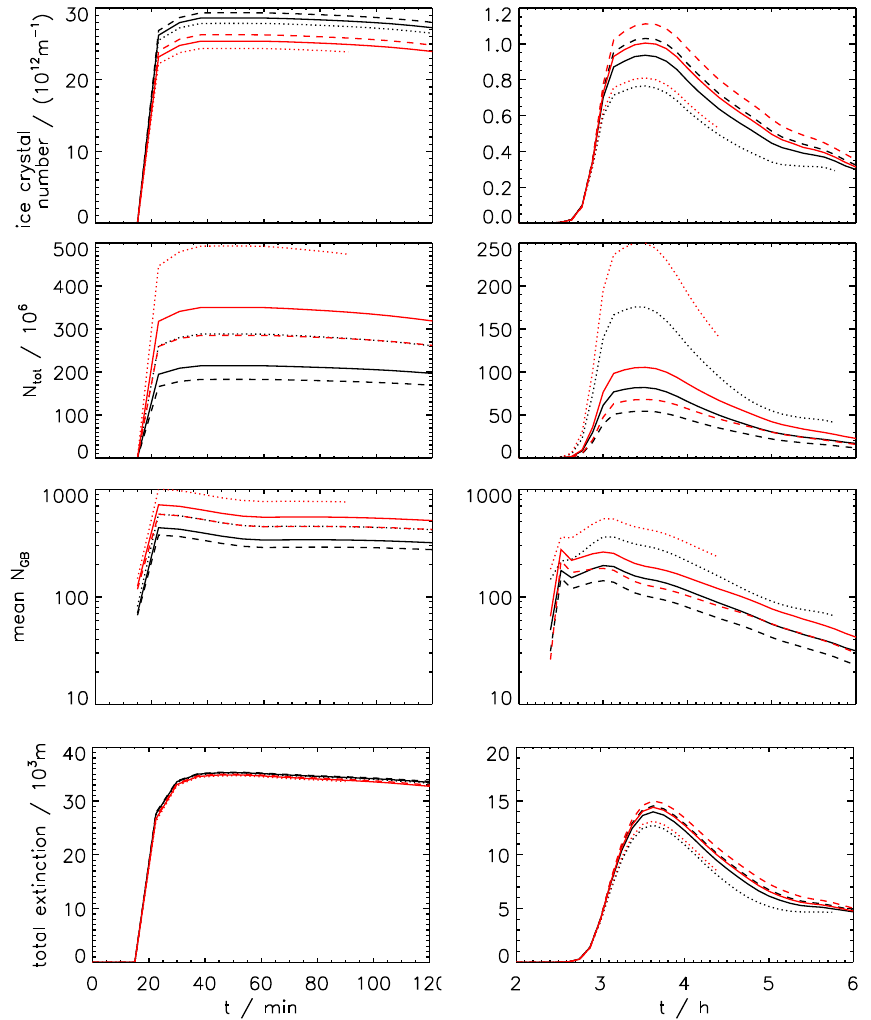
Fig. 6. Temporal evolution of total ice crystal number N , total SIP number N tot , average SIP number per grid box N mean and total extinction E for a strong short updraught ( w syn = 20cms − 1 , left) and a weak longer-lasting updraught ( w syn = 2cms − 1 , right). The minimum number n min (in units m − 3 ) of ice crystals represented by a new SIP is 100 (dashed), 50 (solid) or 10 (dotted). The freezing time step ∆ t NUC is either 0 . 2s (red) or 0 . 4s (black).